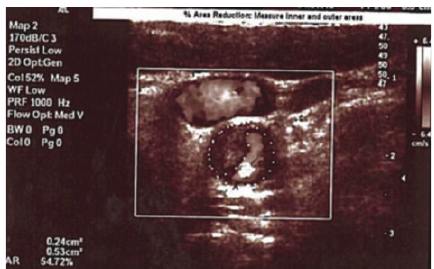
Figure 2: Carotid doppler ultrasonography shows left carotid artery with thrombus